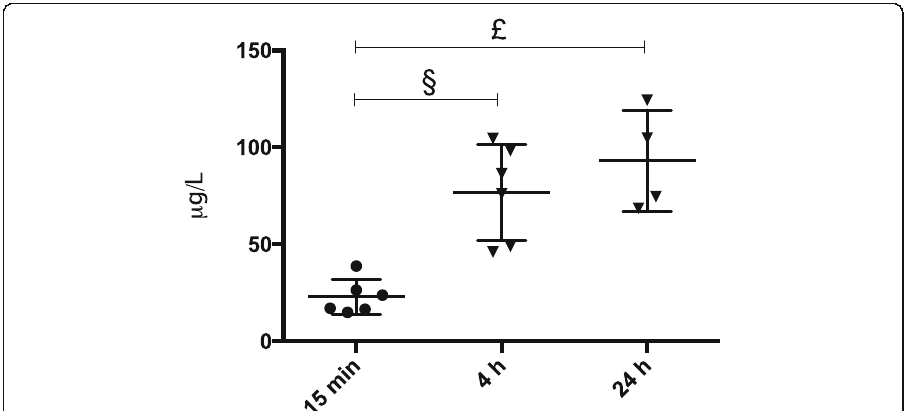
Fig. 7 Nalbuphine plasma levels. Nalbuphine plasma levels at 15 min (sham nalbuphine, n =6), 4 h (sepsis nalbuphine, n =6) and 24 h (sepsis nalbuphine, n =4). Samples were obtained from independent animals without repeated blood sampling (one-way ANOVA p <0.001). Post-hoc test revealed significantly higher plasma levels at 4 h (§: p =0.002) and 24 h (£: p <0.001) vs 15 min. There was no significant difference between 4 and 24